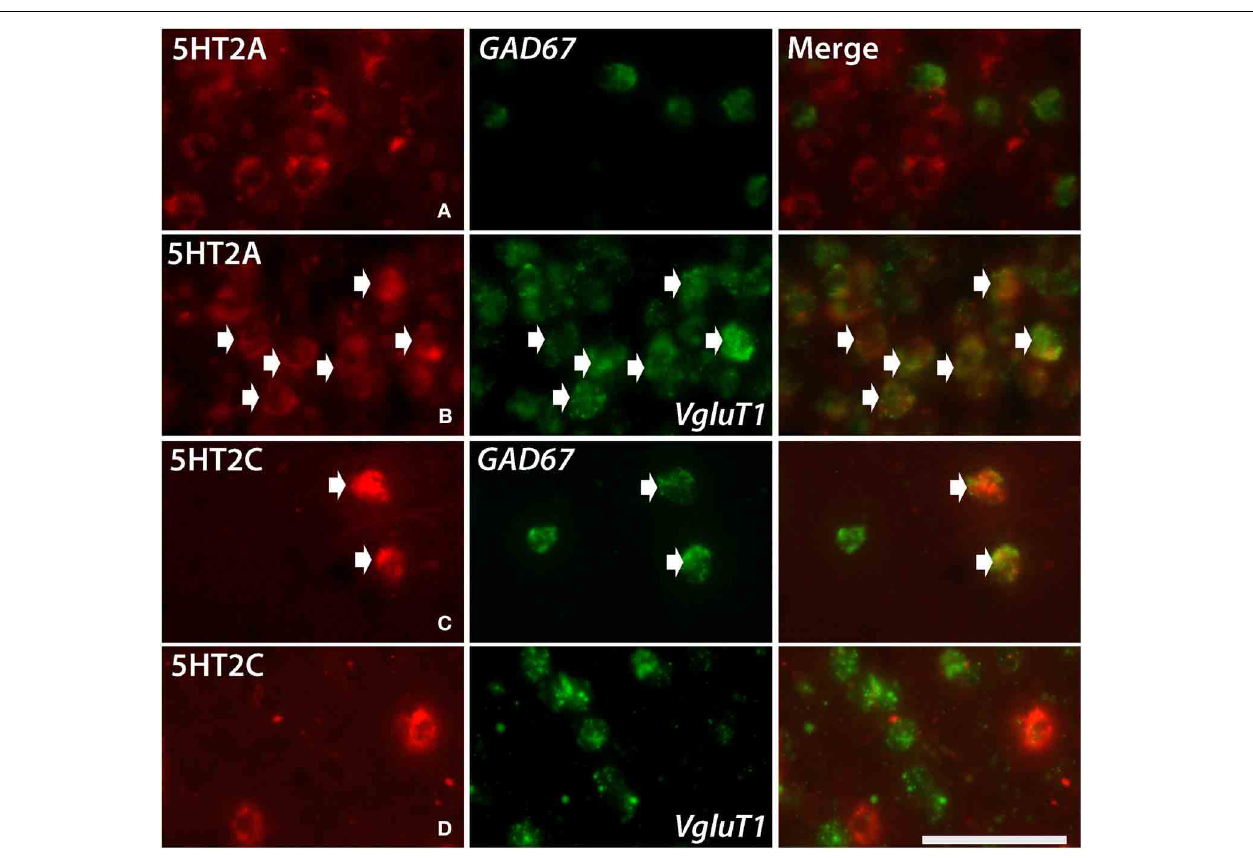
FIGURE 5 | Double ISH of 5HT2C and 5HT2A (red, DIG) with GAD67 and VgluT1 neuronal markers (green, FITC). 5HT2A with GAD67 in layer III of V1 (A) , 5HT2A with VgluT1 in layer III of V1 (B) , 5HT2C with GAD67 in layer V of frontal cortex (C) and 5HT2C with VgluT1 in layer V of frontal cortex (D) .